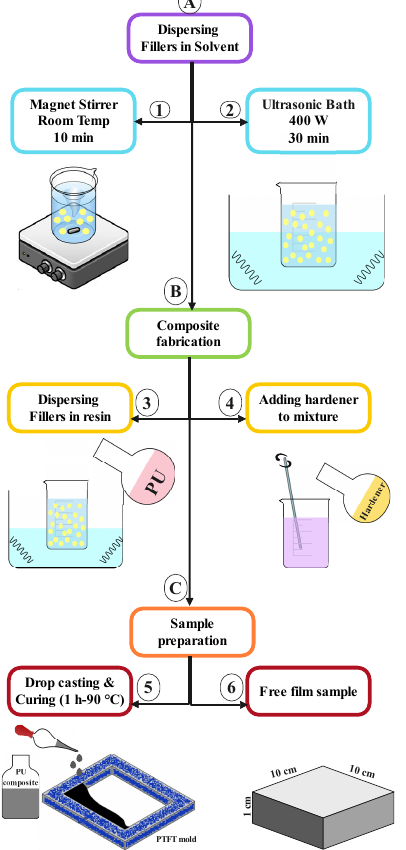
Figure 1. Fabrication of the PU composites via the drop casting